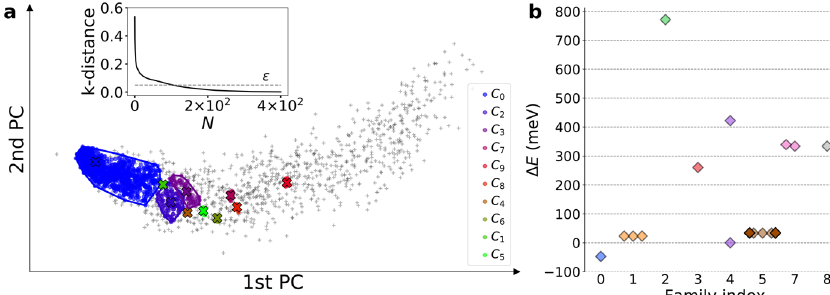
Fig. 10 Structures and local minima found at the DFT + U level. a The clusters found among the visited structures of an EA run for the □ O in anatase TiO 2 . Cluster centroids are shown with crosses. The inset shows the k -distance plot used to fi nd the clustering parameter ε . Cluster names are ordered in the legend according to their size. b Distribution of the minima found at the DFT + U level from the selected